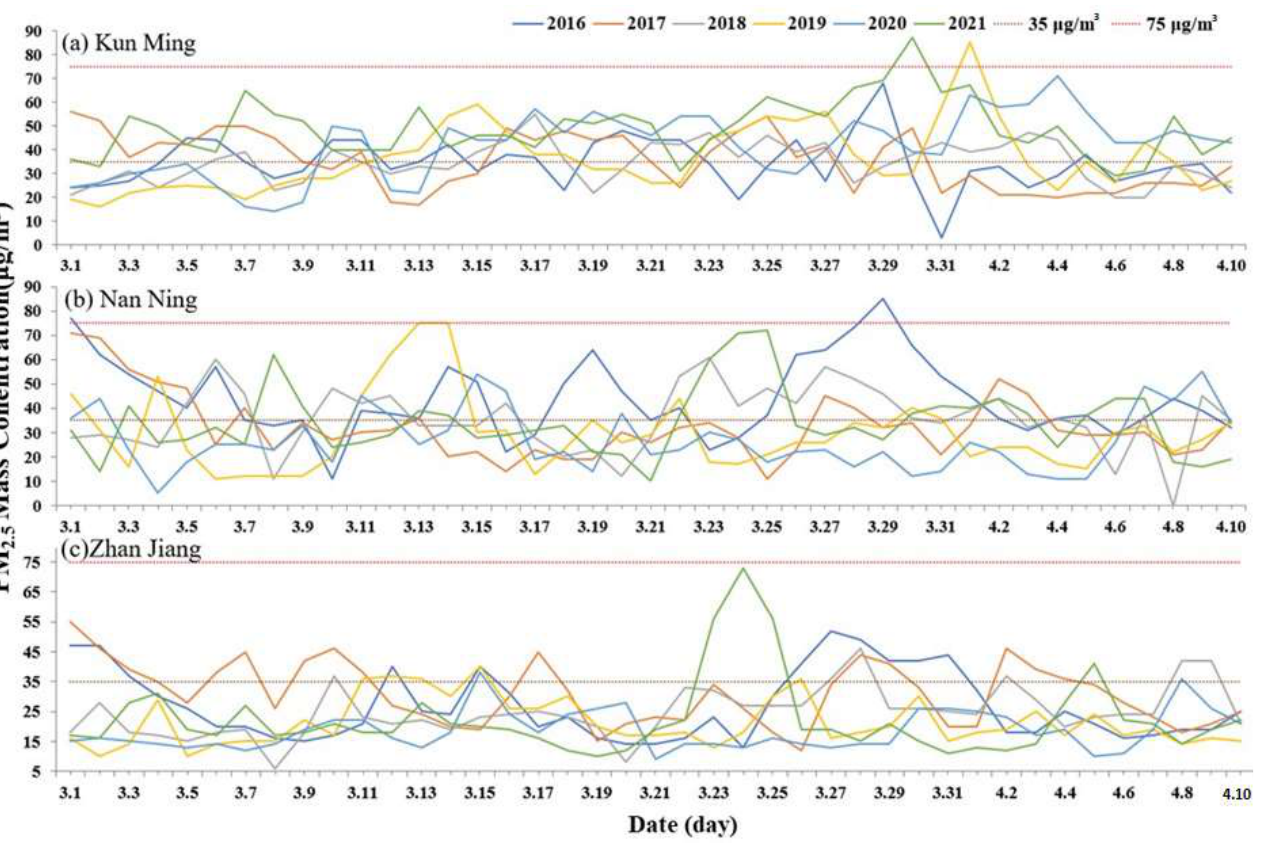
Figure 9. Backward trajectories of polluting air mass in Guangxi on 24 March ( a ) Yunnan on 30 March, ( b ) and Guangdong on 31 March, ( c ) at different altitudes above ground level. (Red: 500 m; Blue: 1000 m; Green: 1500 m).